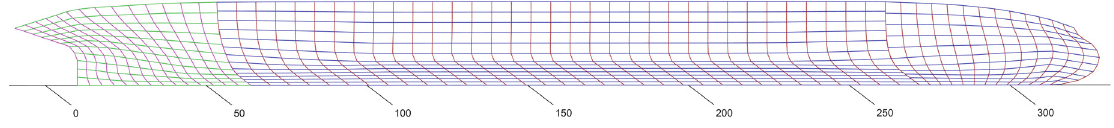
Figure 1. Panelization of the underwater hull of S-Cb84 model for 3D panel code NEWDRIFT.